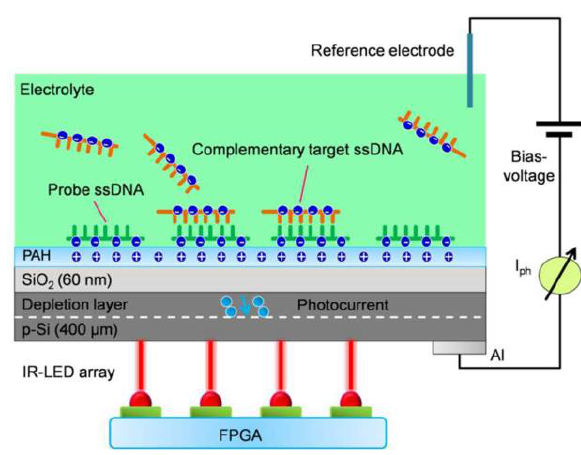
Figure 2. Schematic view of layer structure of a DNA biosensor. Republished with permission of the Royal Society of Chemistry, from [43].